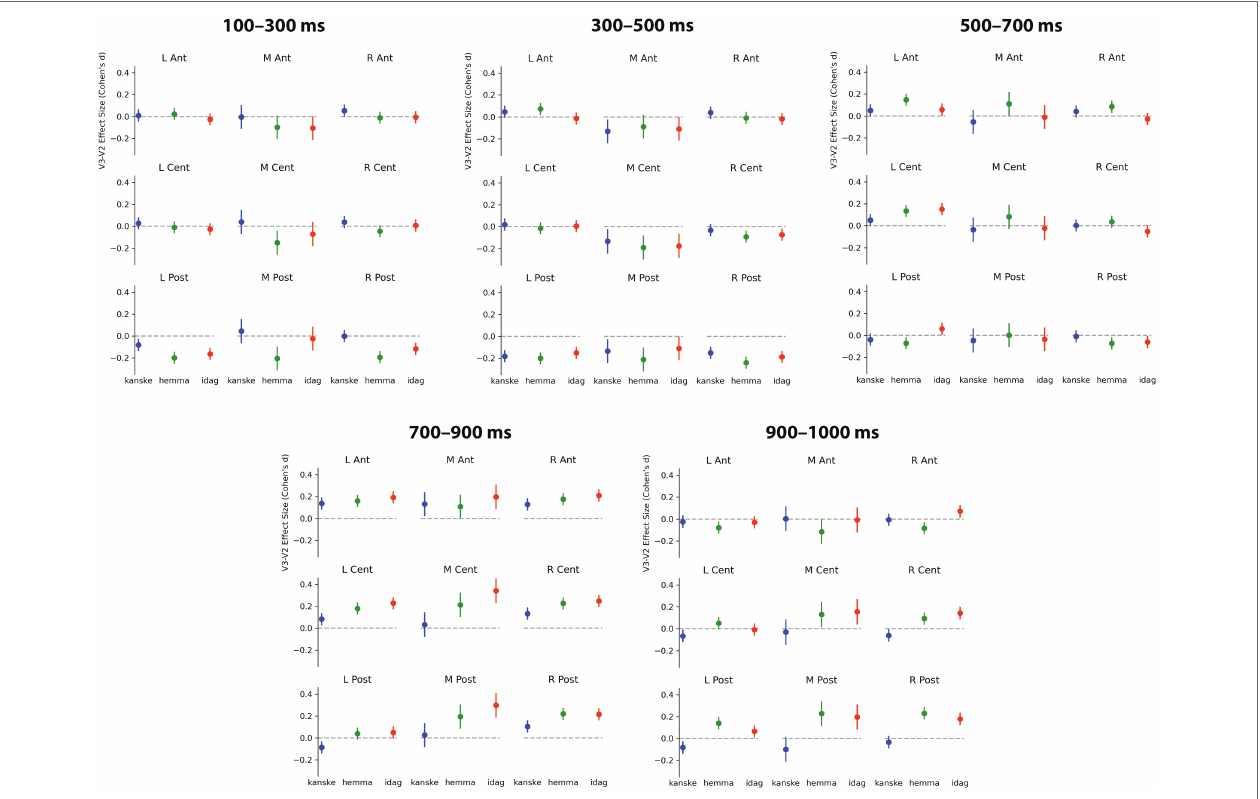
FIGURE 7 | The effect sizes from the linear effects model for the effects (V2 subtracted from V3) of word order (sentence position) with each adverbial for each time window and ROI. Effect sizes (Cohen’s d ) with 95% confidence intervals as error bars shown in blue for kanske , green for hemma and red for idag . L, left; M, medial; R, right; Ant, anterior; Cent, central; Post, posterior. Positive plotted